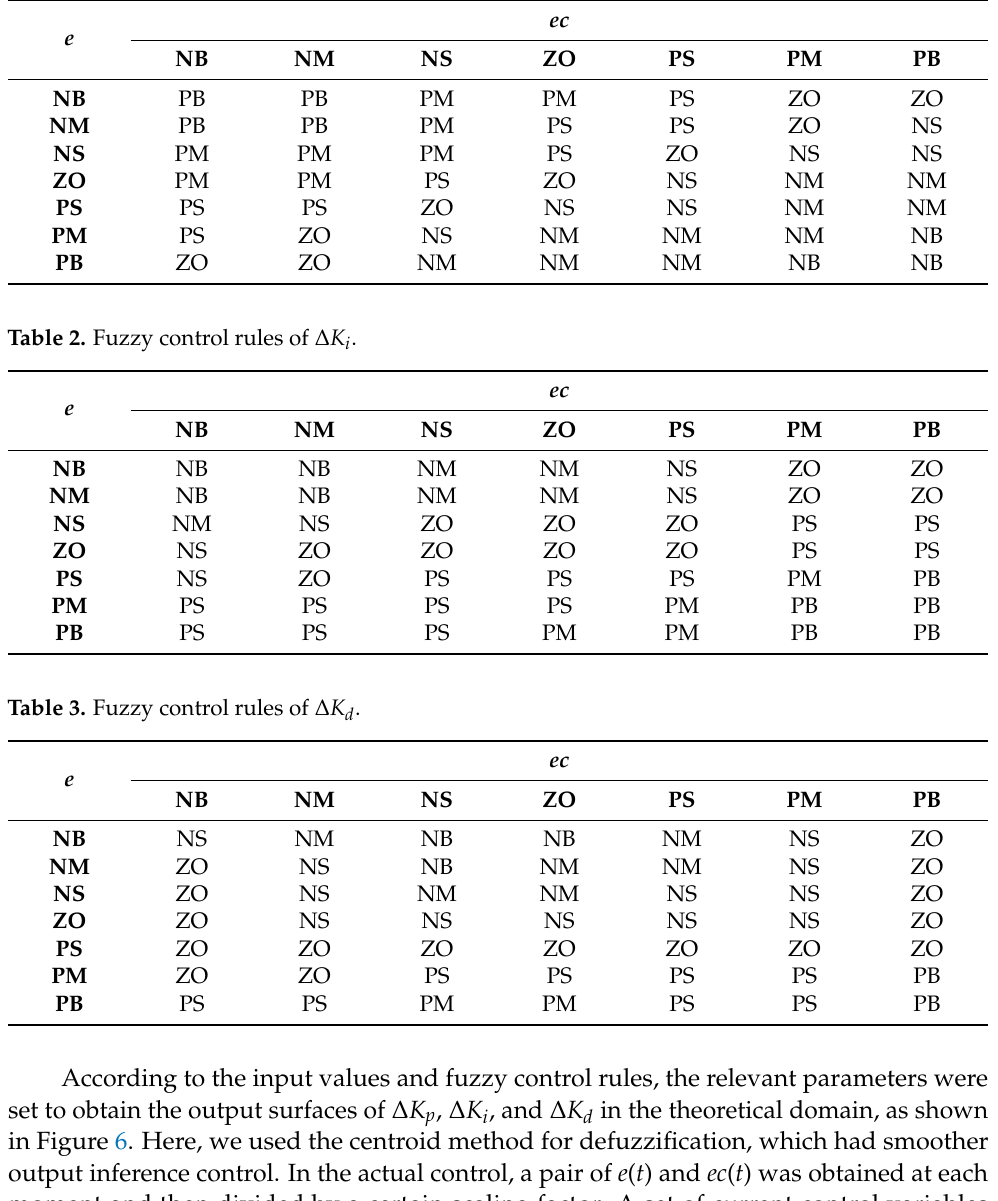
Table 1. Fuzzy control rules of ∆ K p .